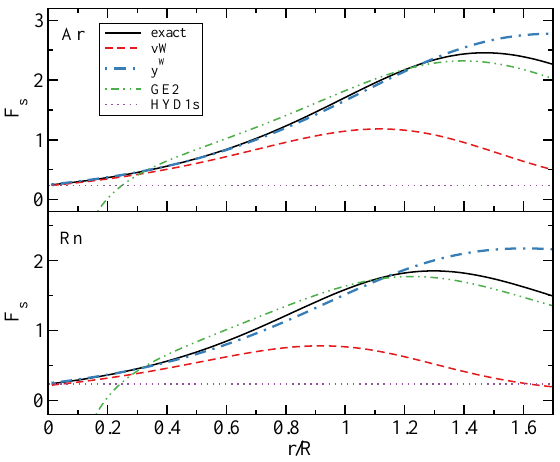
Figure 6. Kinetic energy enhancement factors F s versus scaled radial distance, for the Ar atom (upper panel) and the Rn atom (lower